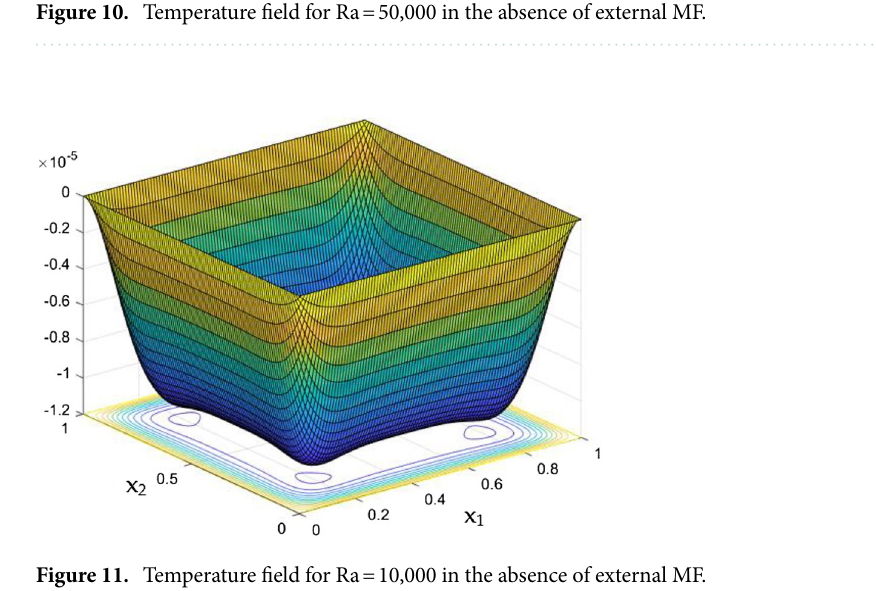
Figure 11. Temperature field for Ra = 10,000 in the absence of external MF.